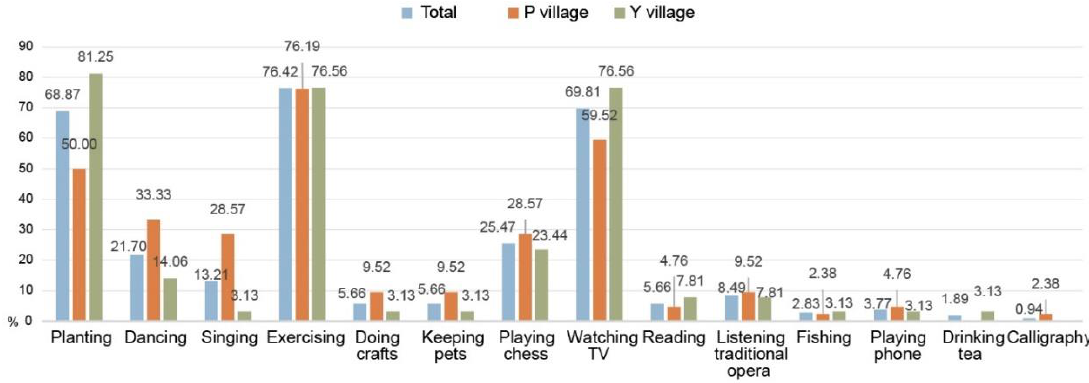
Figure 3. Statistics chart of respondents ’ hobbies.